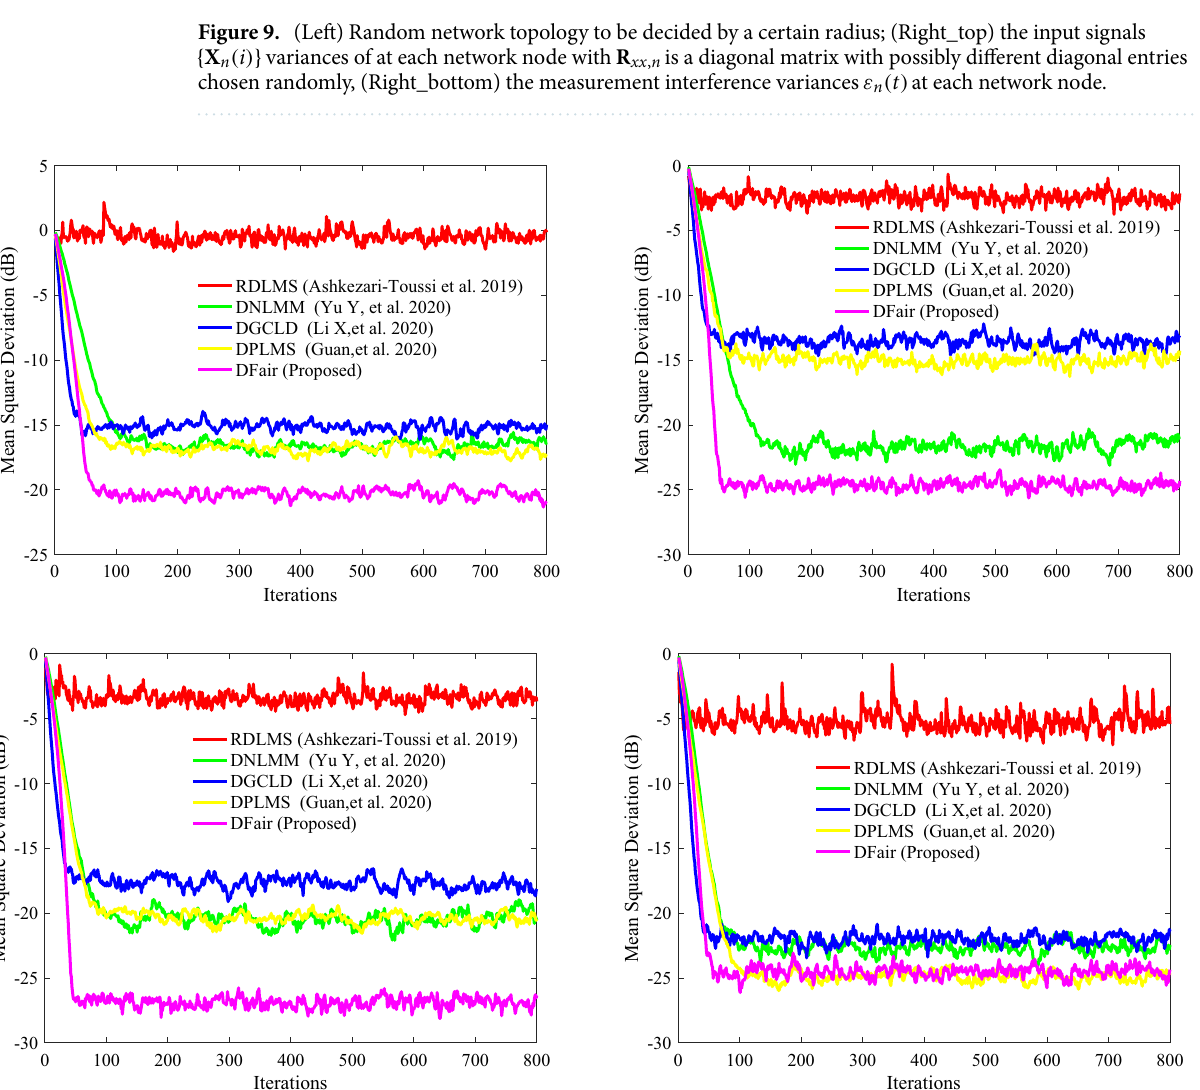
Figure 10. Transient network MSD (dB) iteration curves of the RDLMS, DNLMM, DGCLD, DPLMS, and DFair algorithms. (Up_Left) with, σ 2 f = 0.04 , (Up_right) with σ 2 f = 0.06 , and (Down_left) with σ 2 f = 0.08 , and (Down_Right) with σ 2 f = 0.1